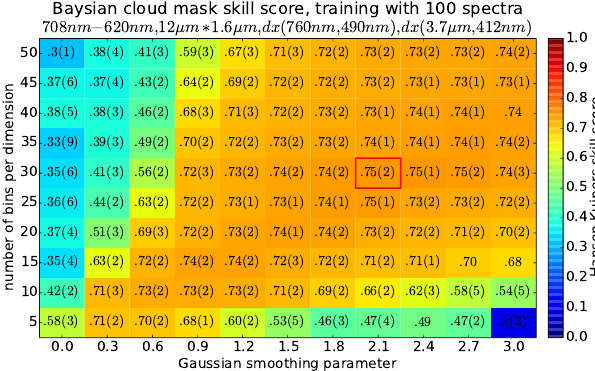
Figure 8. Skill score of a classical Bayesian cloud mask with four strongly independent features with respect to number of bins for each dimension of the underlying histograms and the applied Gaus- sian smoothing. Artificial truth data are taken from 2007 and skill scores were computed for the year 2008. Only 100 randomly se- lected and globally distributed spectra were used to compute the histograms. This selection was repeated 10 times and mean values for the skill score are shown. The standard deviation on the last sig- nificant digit is shown in